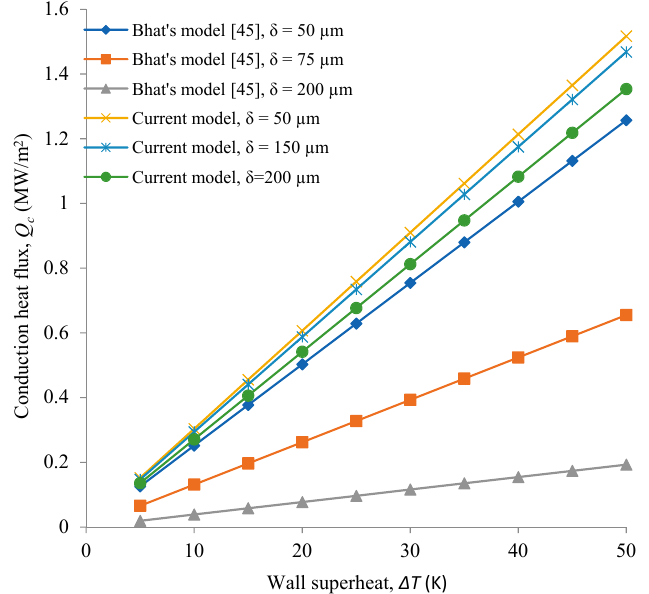
Figure 1. Dependence of heat flux on wall superheat using current model and Bhat’s model.